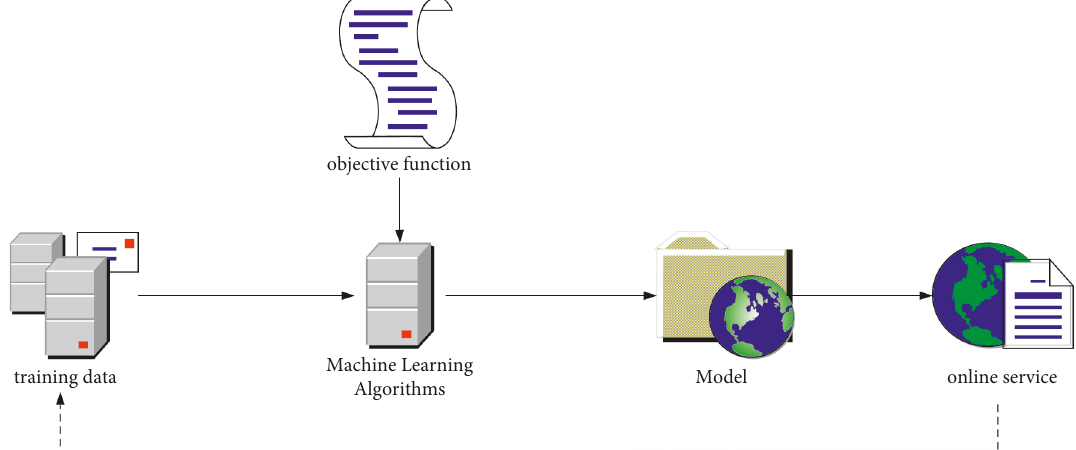
Figure 4: Machine learning problem solving flowchart.